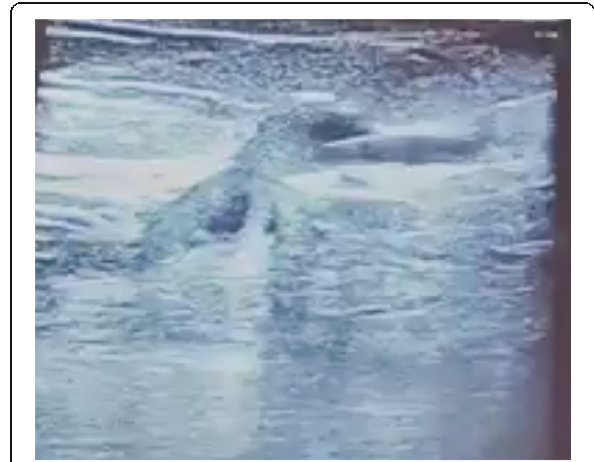
Fig. 2 The US guidance of the needle penetrating the superficial part of the refluxing perforator and injection of the foam causing acoustic